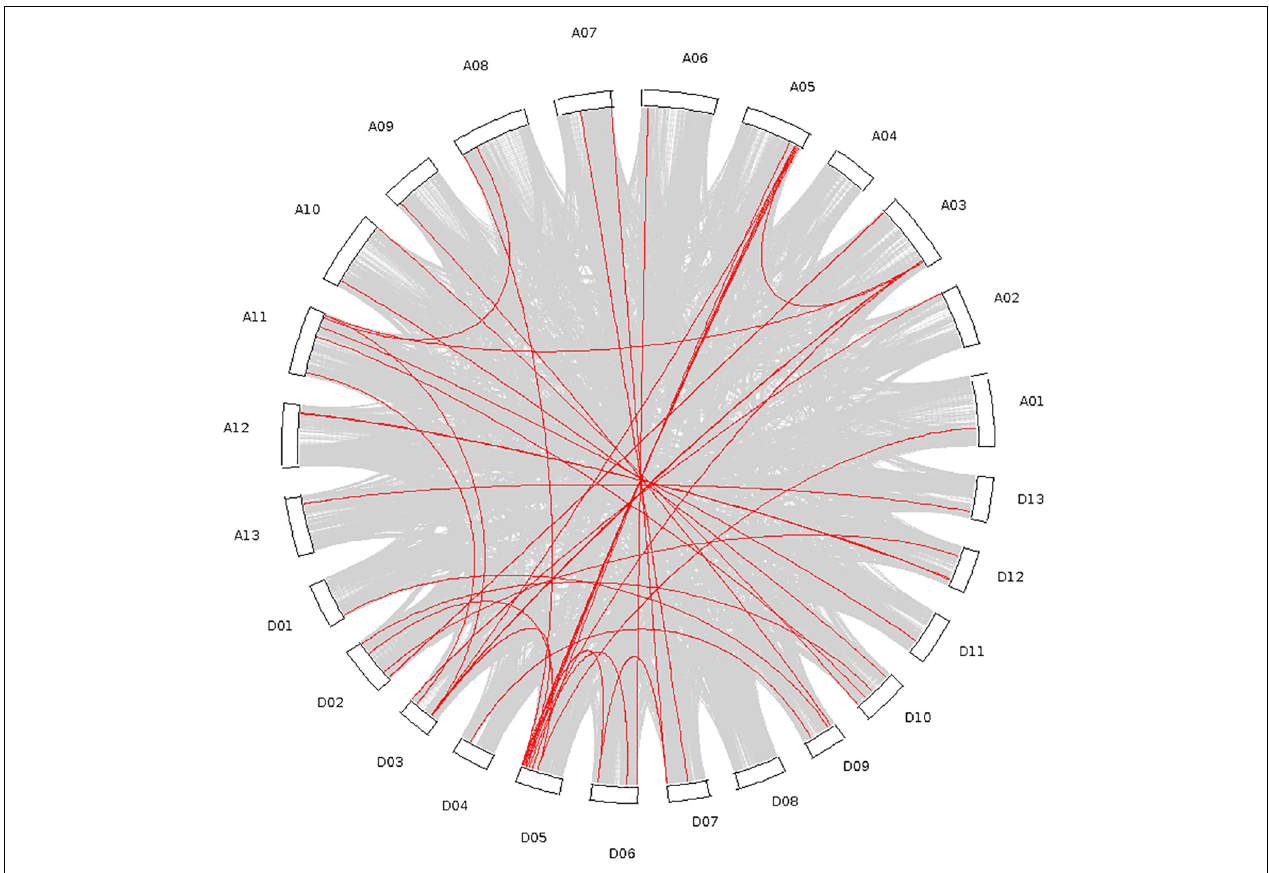
FIGURE 5 | Collinearity analysis of the whole upland cotton genome and P450 family